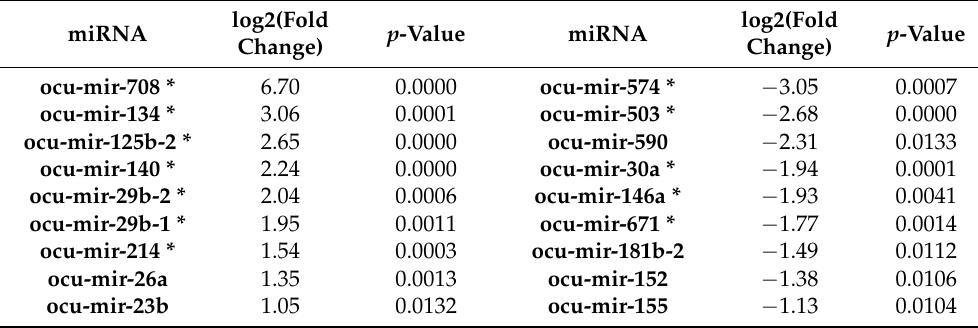
Table 2. List of significantly up/down-expressed hairpin microRNAs (miRNAs): Exo-A versus Exo-G. * Significant expression of both mature and hairpin